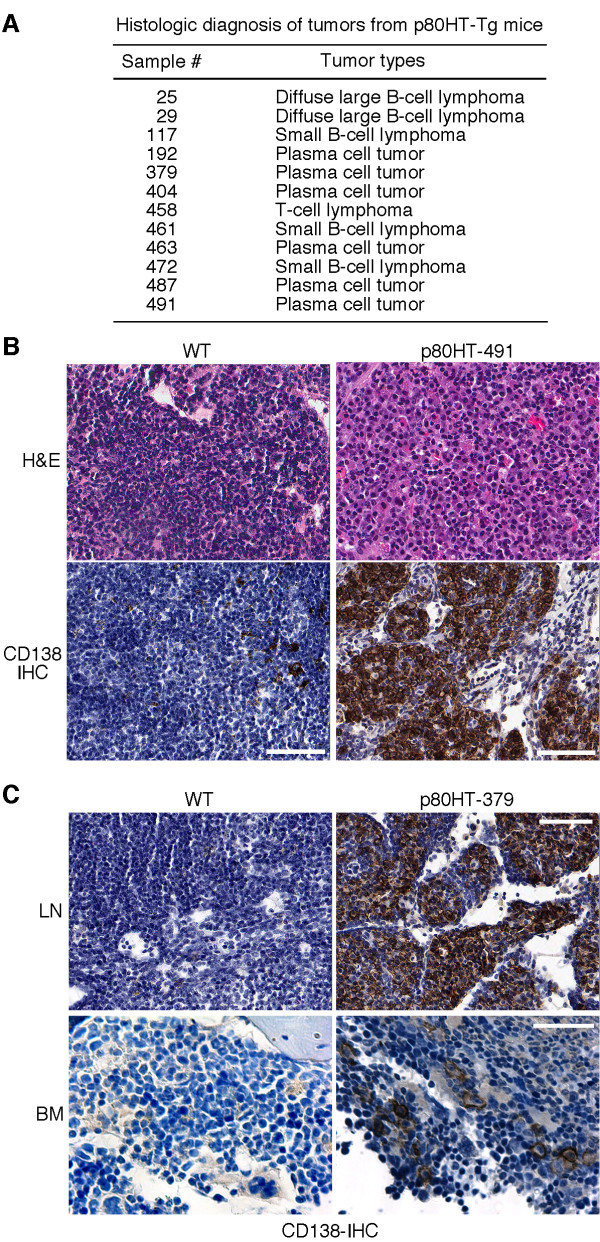
Development of plasma cell tumors in p80HT mice. (A) A summary of histological examination of tumor samples (lymph nodes) from p80HT mice. (B) Hematoxylin and Eosin (H&E) and CD138 immunohistochemistry staining (CD138-IHC) of the lymph node from a wild-type (WT) mouse and a representative tumor sample from the p80HT mouse #491. The tumor sample shows nodules of plasma cells expressing CD138. (C) CD138 immunohistochemistry staining showing accumulation of plasma cells in both the tumor (LN) and bone marrow (BM) samples from the p80HT mouse #379. Scale bars, 50 μm.